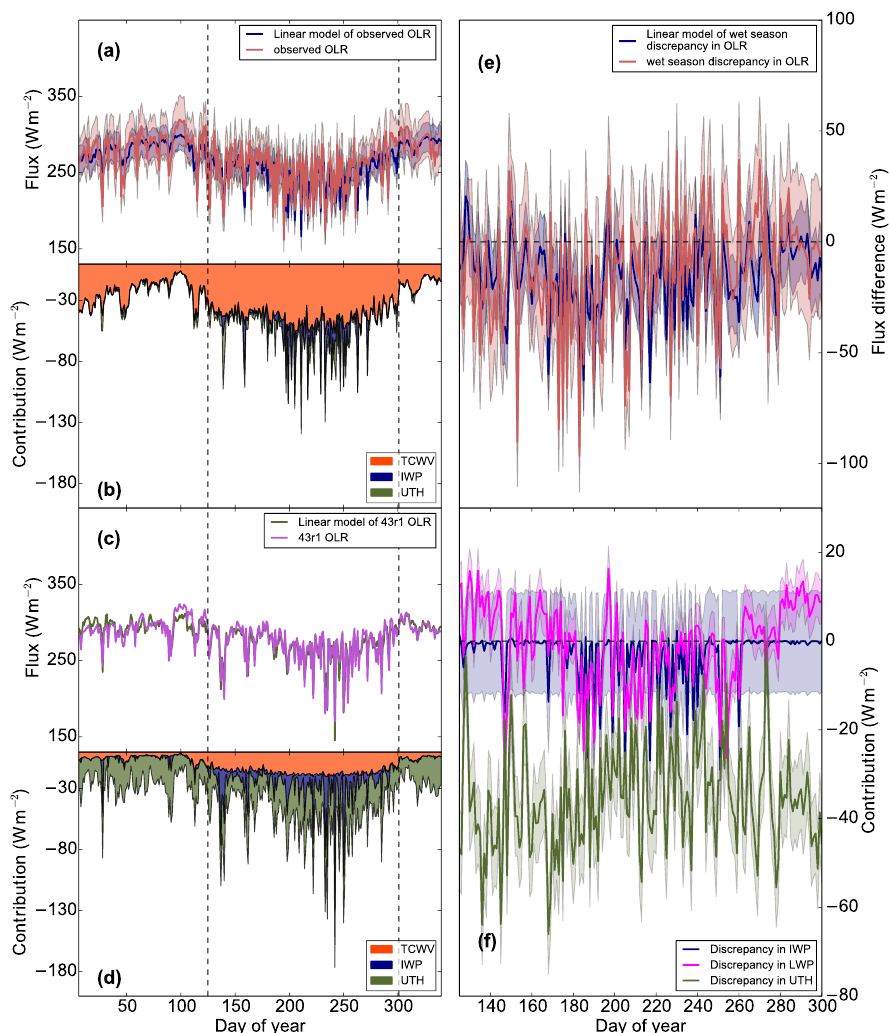
Figure 11. The same as Fig. 7 but for outgoing longwave radiation at the TOA, with observation–43r1 linear model contributions from TCWV (orange), IWP (blue) and UTH (green) in plots (b) and (d) , and discrepancy model contributions from IWP (blue) and UTH (green) and LWP (pink) in plot (f) . Negative contributions in plots (b) , (d) and (f) indicate that an increase in that variable corresponds to a decrease in